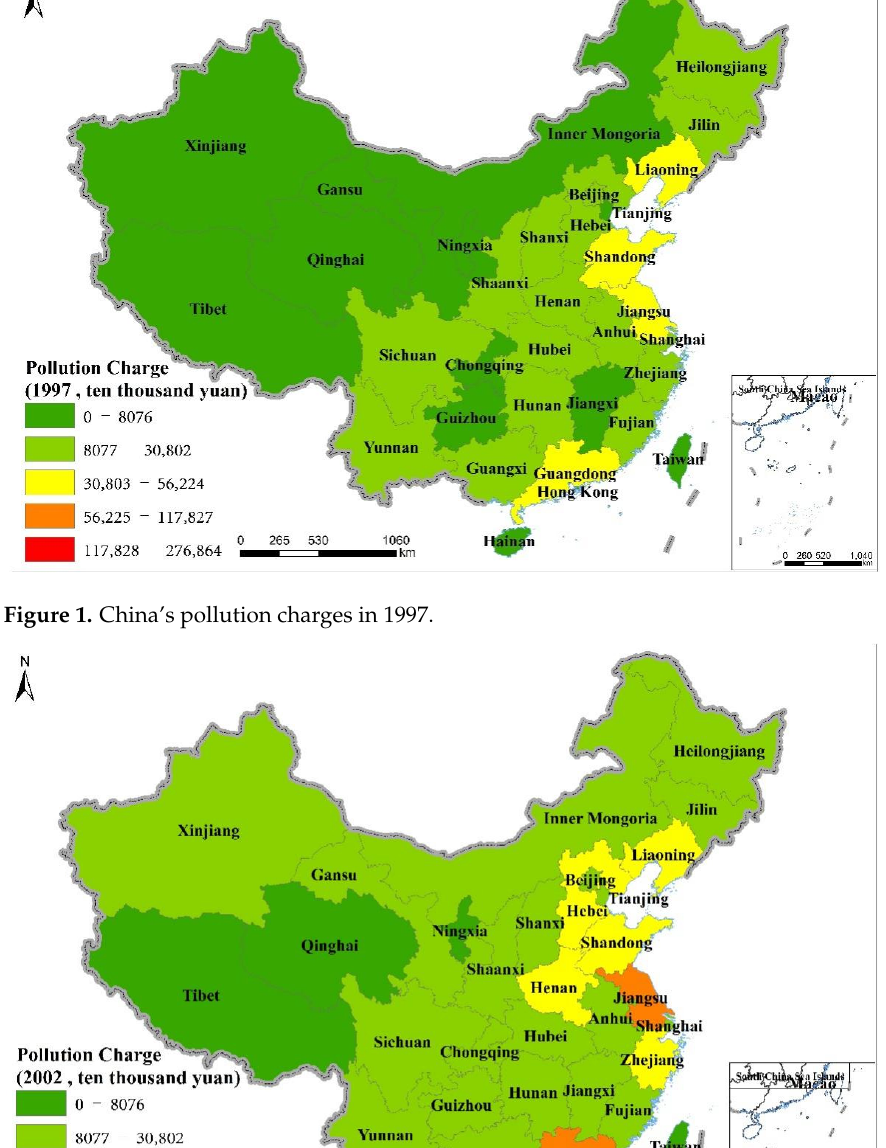
Figure 3. China’s pollution charges in 2007.